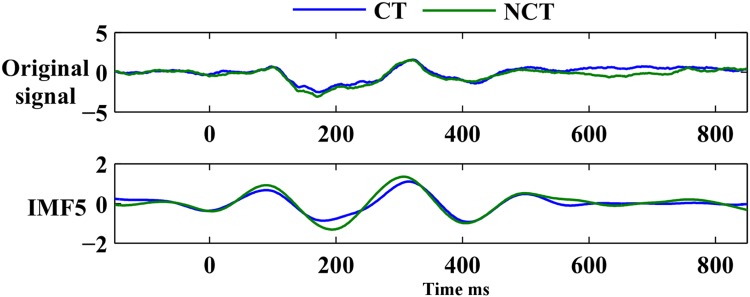
Comparison of the original EEG recording (grand average over 18 subjects of channel O2) with ERM 5.